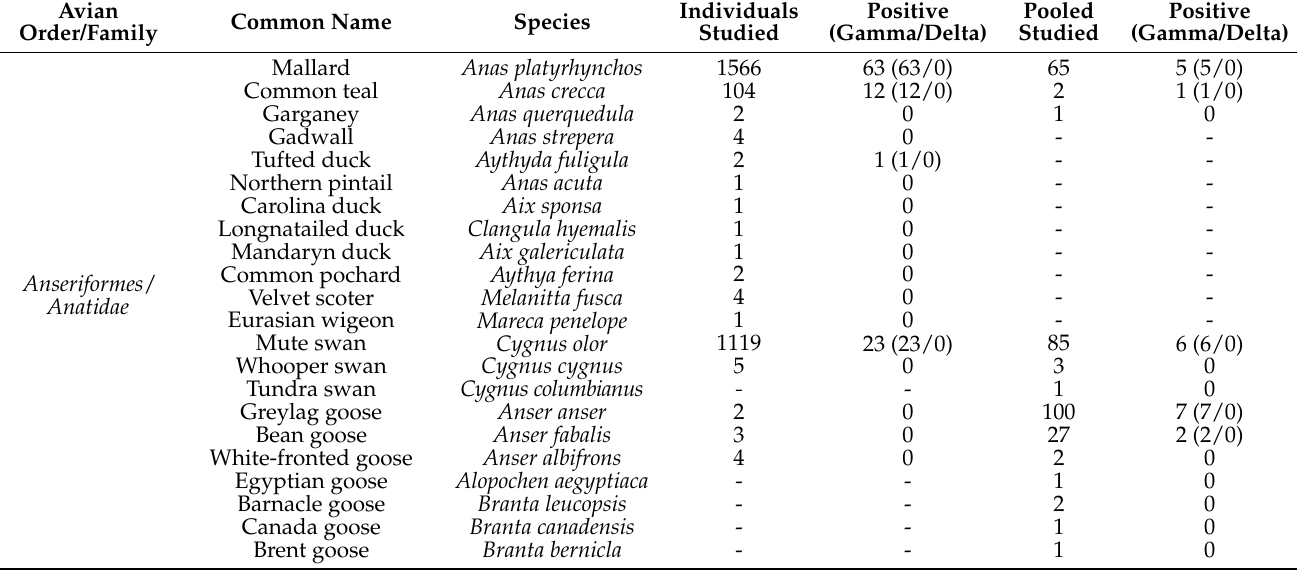
Table 1. Birds screened in this surveillance and an overview of the prevalence of coronaviruses in the studied samples. Avian